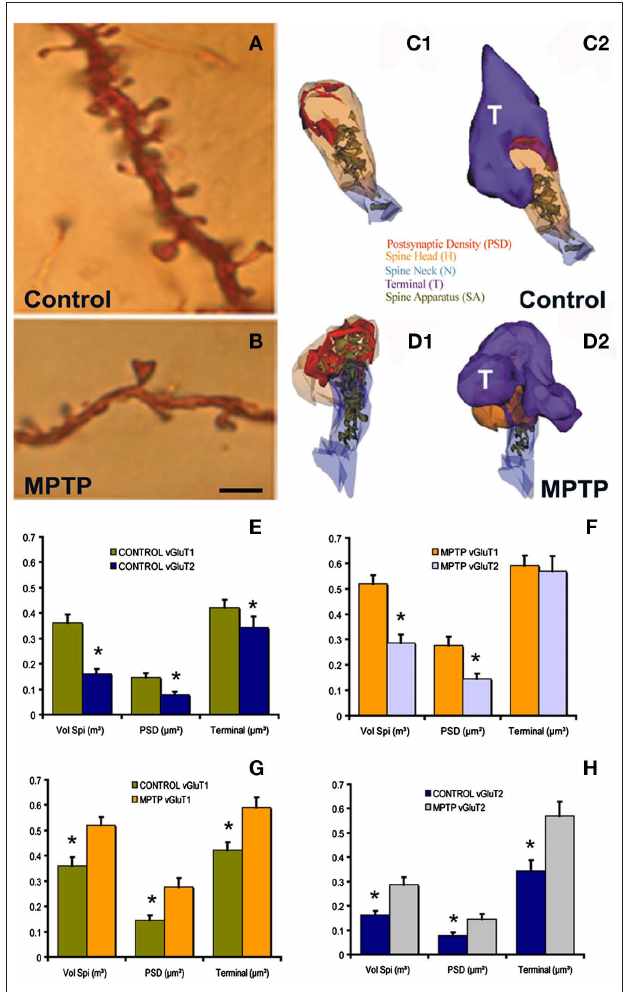
Figure 1 | Morphological and ultrastructural changes in striatal MSNs after MPTP treatment. (A,B) Dendrites from Golgi-impregnated MSNs in the caudate nucleus of a control (A) and a MPTP-treated (B) monkey showing the dramatic spine loss (30–50%) after MPTP treatment. (C1–D2) Three- dimension (3D)-reconstructed images of glutamatergic axo-spinous synapses from a control (C1,C2) and a MPTP-treated (D1,D2) monkeys. The spines are partially transparent to better show and compare the complexity and distribution of the spine apparatus (SA) between control and MPTP-treated monkeys. (e,F) Histograms comparing the morphometric measurements (mean ± SEM; spine volume, PSD area, terminal volume) of structural elements at corticostriatal (vGluT1-positive) and thalamostriatal (vGluT2- positive) glutamatergic synapses using the 3D reconstruction method of serial ultrathin sections collected from 30 axo-spinous synapses in each group from three control and three MPTP-treated animals. The units used for these measurements are indicated in the X axis within parentheses. In control monkeys ( N = 3), the spine volume (Vol. Sp.), the PSD areas, and the size of pre-synaptic terminals at corticostriatal synapses are significantly larger than those at thalamostriatal synapses [ * , t -test, P < 0.001 for Vol. Sp. and PSD; P = 0.016 for terminal (e) ]. The same is true for MPTP-treated monkeys ( N = 3), except for the pre-synaptic terminals that do not show any significant size differences in this condition (F) . (g,H) The spine volumes, the PSD areas and the volume of vGluT1- and vGluT2-containing terminals are significantly larger in MPTP-treated parkinsonian monkeys than in controls ( * , t -test, P < 0.001). Scale bar in (B) [valid for (A) ]: 5 μm. (see Villalba et al., 2009;